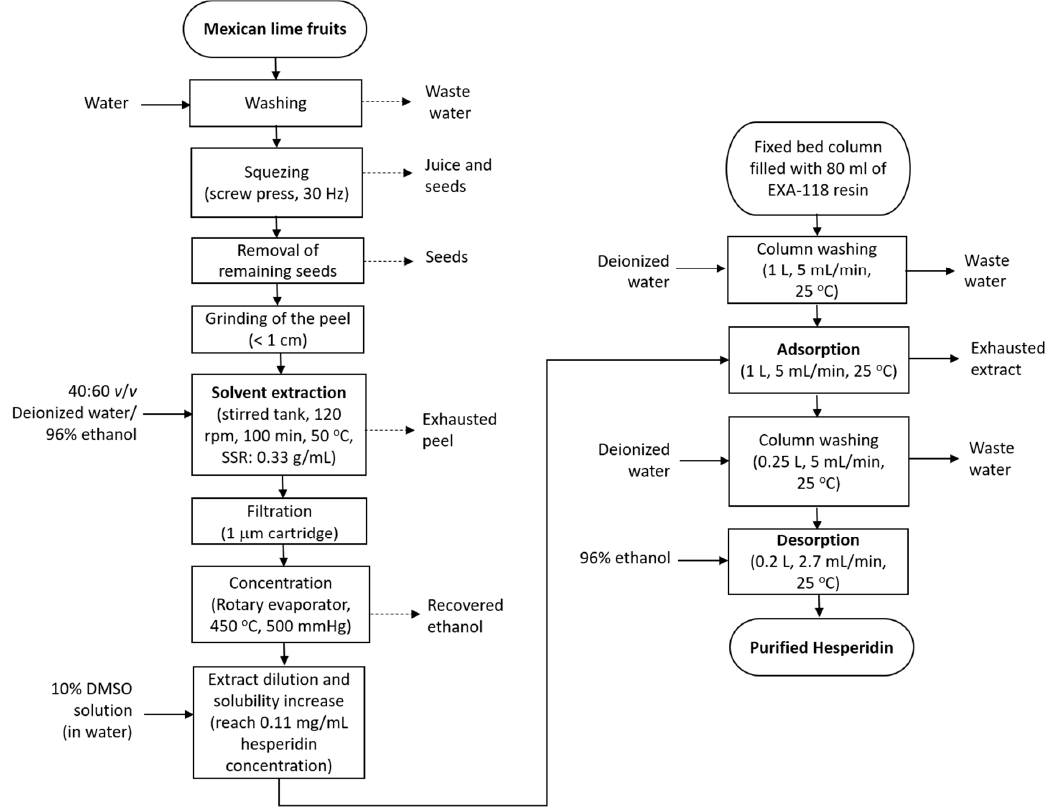
Figure 7. Proposed method by the authors, for the extraction and purification of hesperidin from Mexican lime peel.